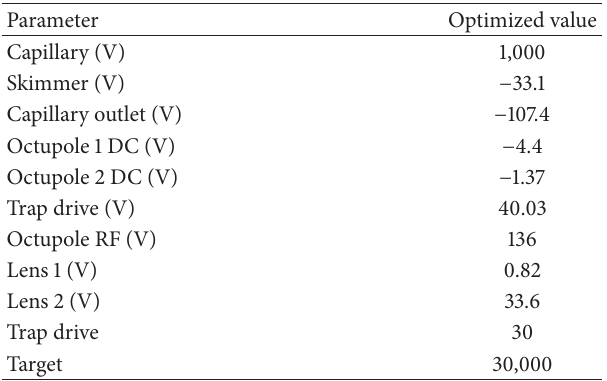
Table 1: Optimized mass spectrometry parameters for the detection of